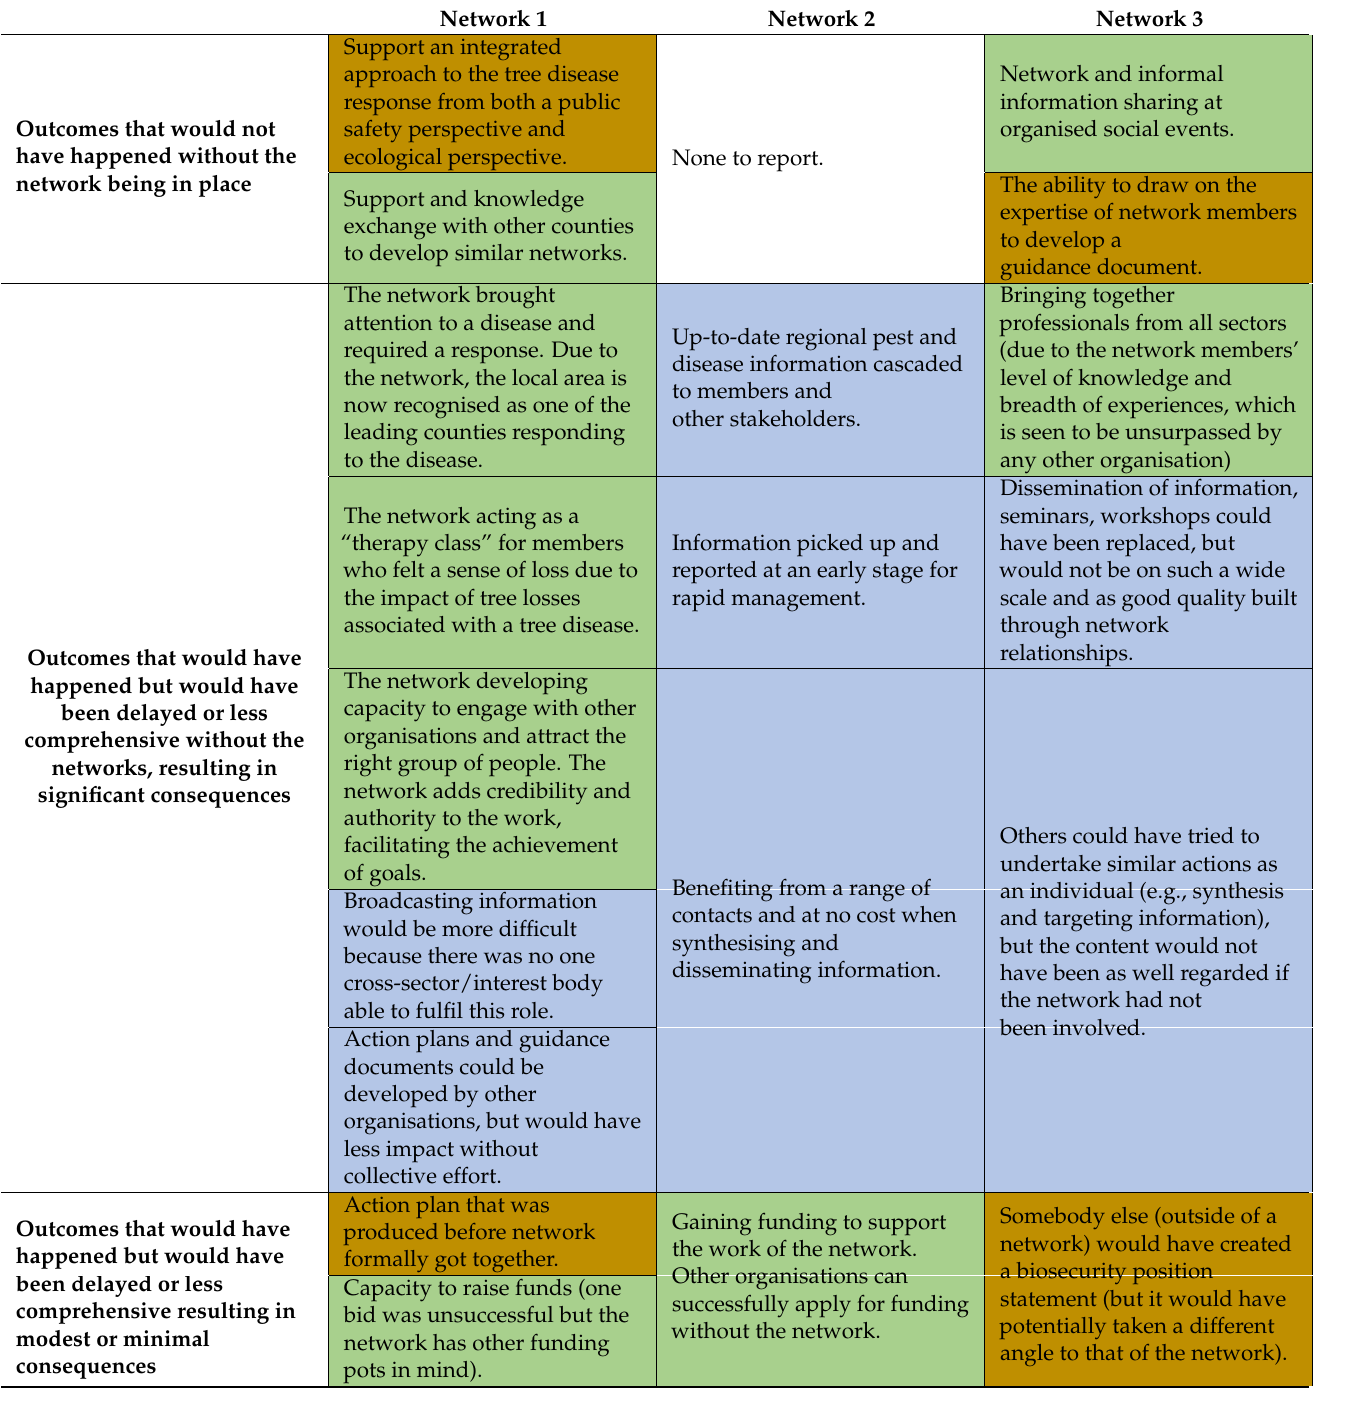
Table 3. Perceptions of the interviewees concerning whether they felt the actions and outcomes of the networks would have occurred even if the network had not existed. The activities of bringing people with expertise together, supporting members and raising funds are coloured in green, synthesising and communicating actions are coloured in blue, and other actions are coloured in